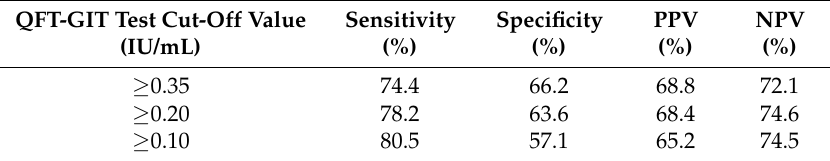
Table 2. Diagnostic accuracy of the QFT-GIT test in the detection of active PTB. QFT-GIT Test Cut-Off Value (IU/mL)